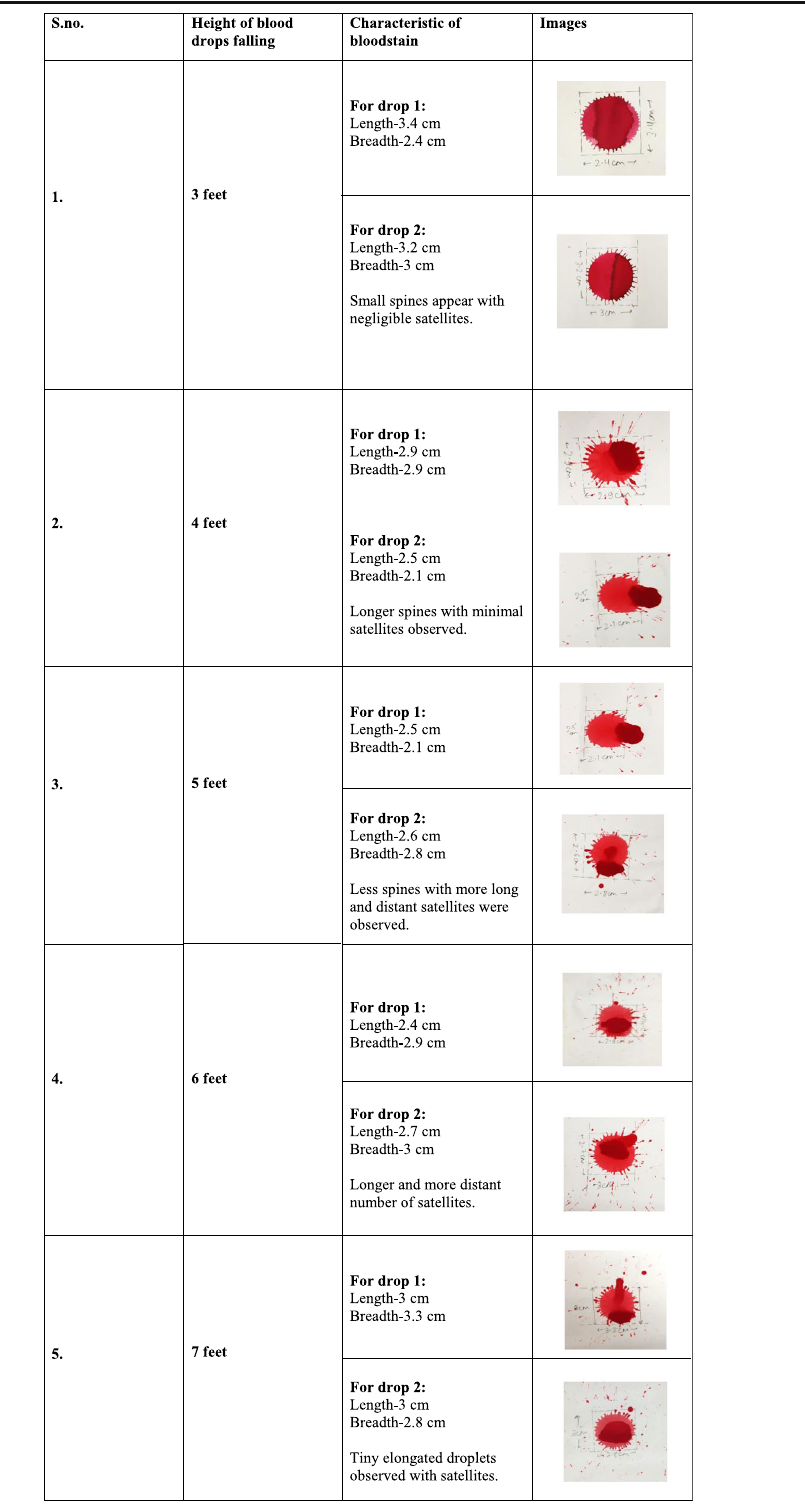
Table 1 Experiment depicting effect of height on formation of blood